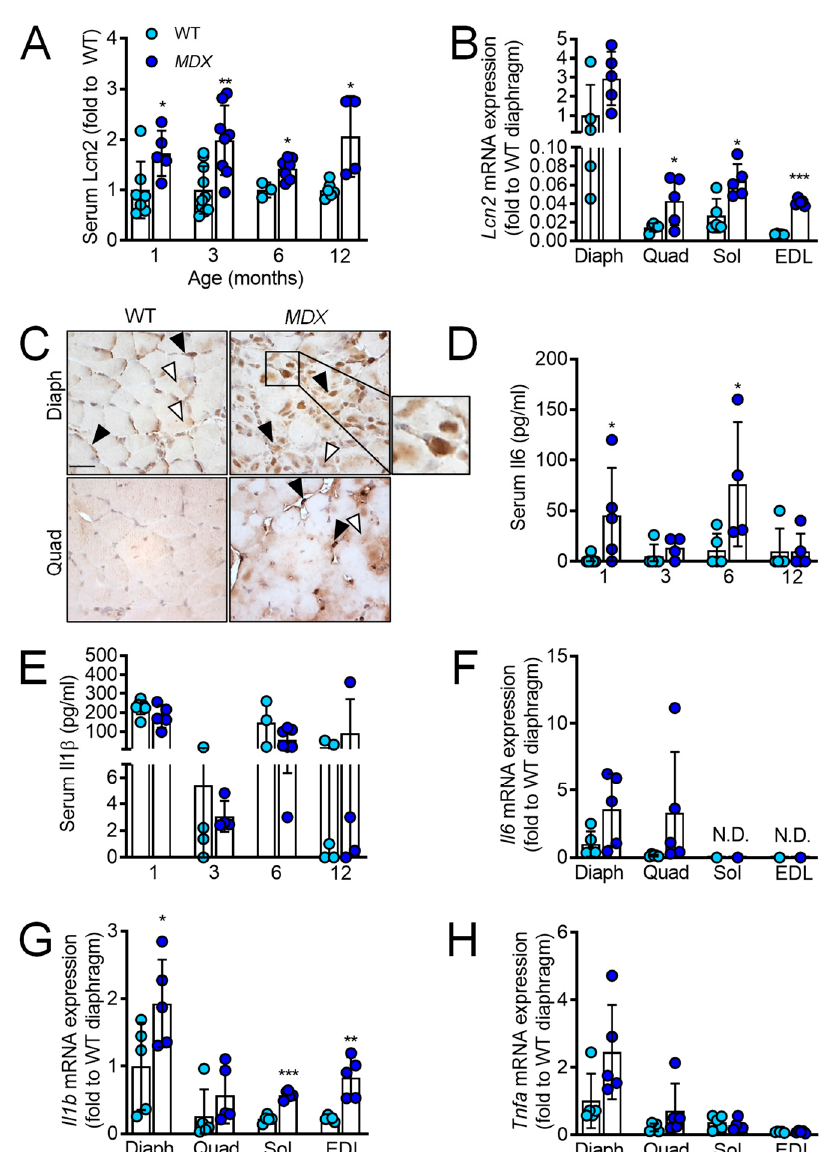
Figure 1. Lipocalin 2 and pro-inflammatory cytokines expression in MDX mice. ( A ) ELISA assay showing Lipocalin 2 (Lcn2) serum levels in WT and MDX mice at the ages indicated in the abscissa. ( B ) Transcriptional expression of Lcn2 in the diaphragm (Diaph), quadriceps (Quad), soleus (Sol), and Extensor Digitorum Longus (EDL) muscles from 1-month-old WT and MDX mice. ( C ) Immunohistochemical analysis of Lcn2 in diaphragm and quadriceps muscle sections from 1-month-old WT and MDX mice (Black arrowhead: mononuclear cells positive for Lcn2; white arrowhead: positivity for Lcn2 in muscle fibres; bar = 25 µ m; inset: magnification of Lcn2-positive mononuclear cells). ( D ) ELISA assay to evaluate the serum levels of Interleukin (IL) 6 and ( E ) IL1 β at the ages indicated in the abscissa. ( F ) Diaphragm, quadriceps, soleus (Sol), and Extensor Digitorum Longus (EDL) transcriptional expression of Il6 , ( G ) Il1b, and ( H ) Tnfa in 1-month-old WT and MDX mice. In ( C ), pictures are representative of three mice/group. In ( A , B , D – H ) results are the mean ± SD of at least three mice/group; N.D. = non-detectable; * p < 0.05, ** p < 0.01 and *** p < 0.001 vs. WT; Student’s t -test.